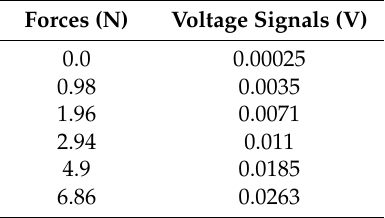
Table 1. Values of forces and the corresponding voltage signal generated during the